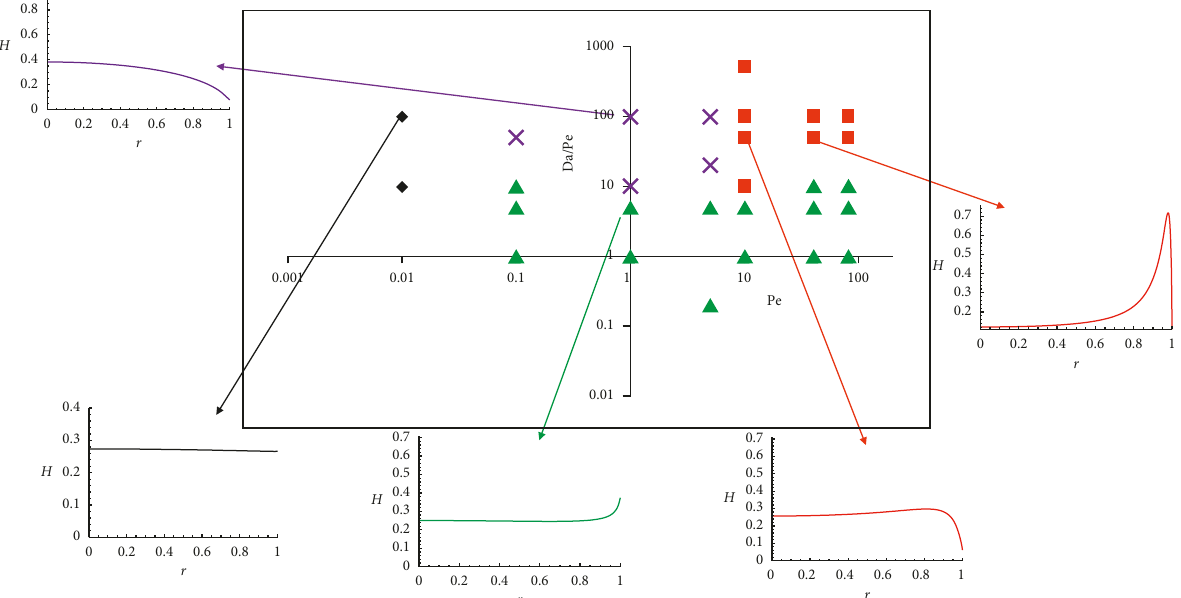
Figure 11: Phase diagram for the deposition under different Da/Pe and Pe numbers with desorption Da